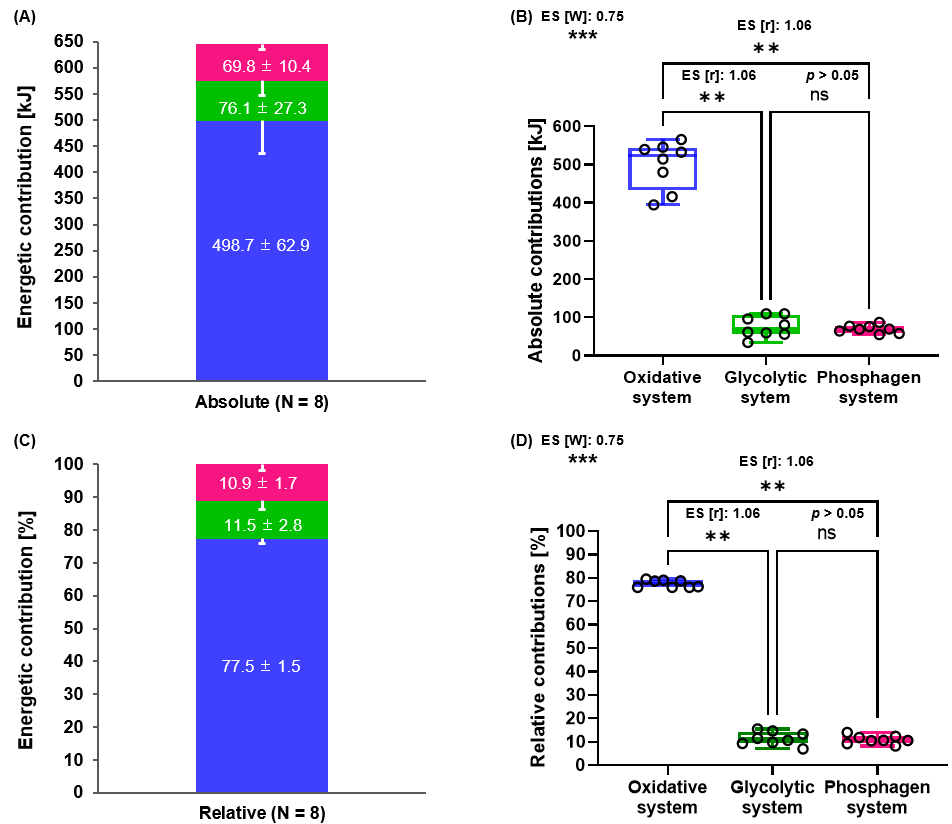
Figure 2. Energetic contributions during 2000 m RTT. Calculated absolute (( A , B ), kJ) and relative (( C , D ), %) energetic contributions in 2000 m RTT. Oxidative energy contribution is shown in blue, glycolytic energy contribution in green, and phosphagen energy contribution in red. Data are mean ± standard deviation (SD) (n = 8). ** p < 0.01, *** p < 0.001, ns: p > 0.05. ES: effect size.